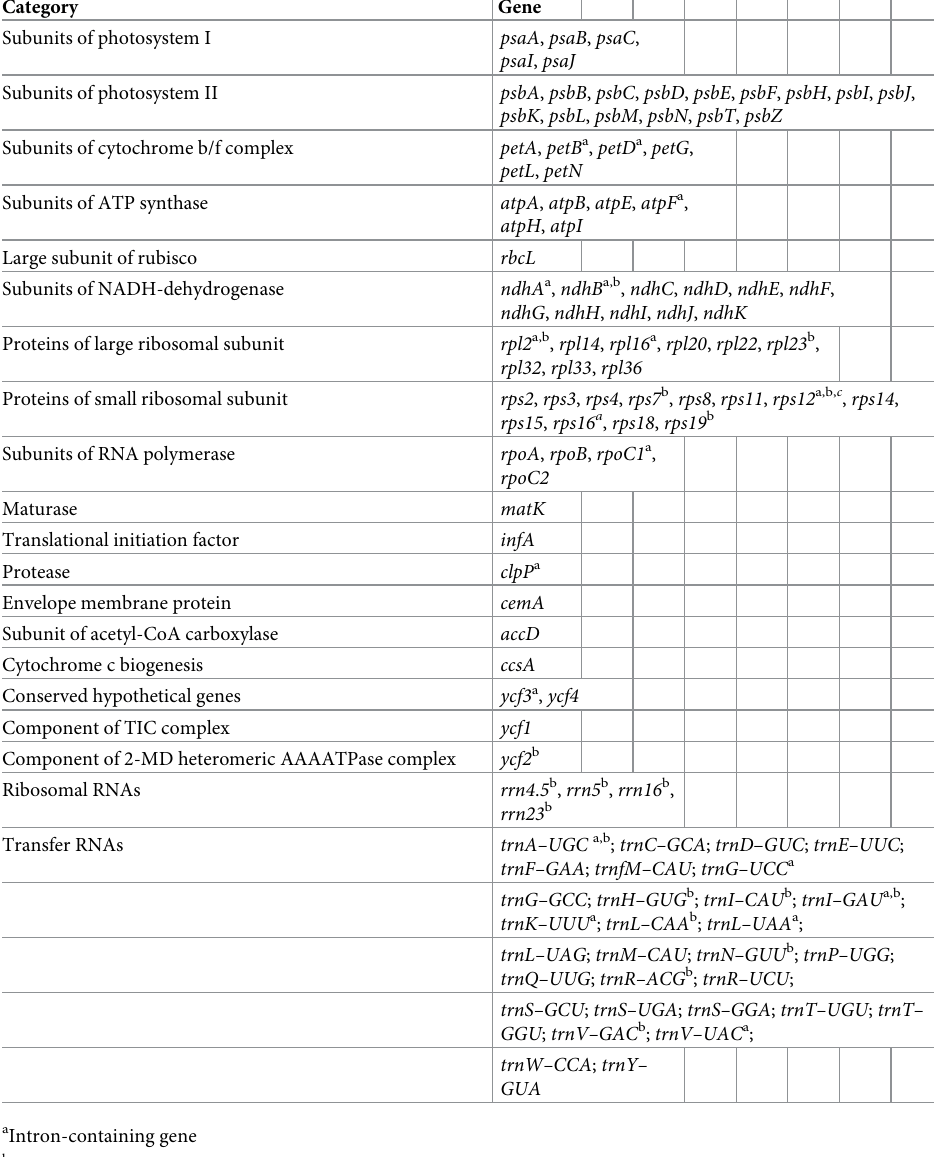
Table 2. Gene content in Euterpe edulis , E . oleracea and E . precatoria chloroplast genomes according to each respective category.